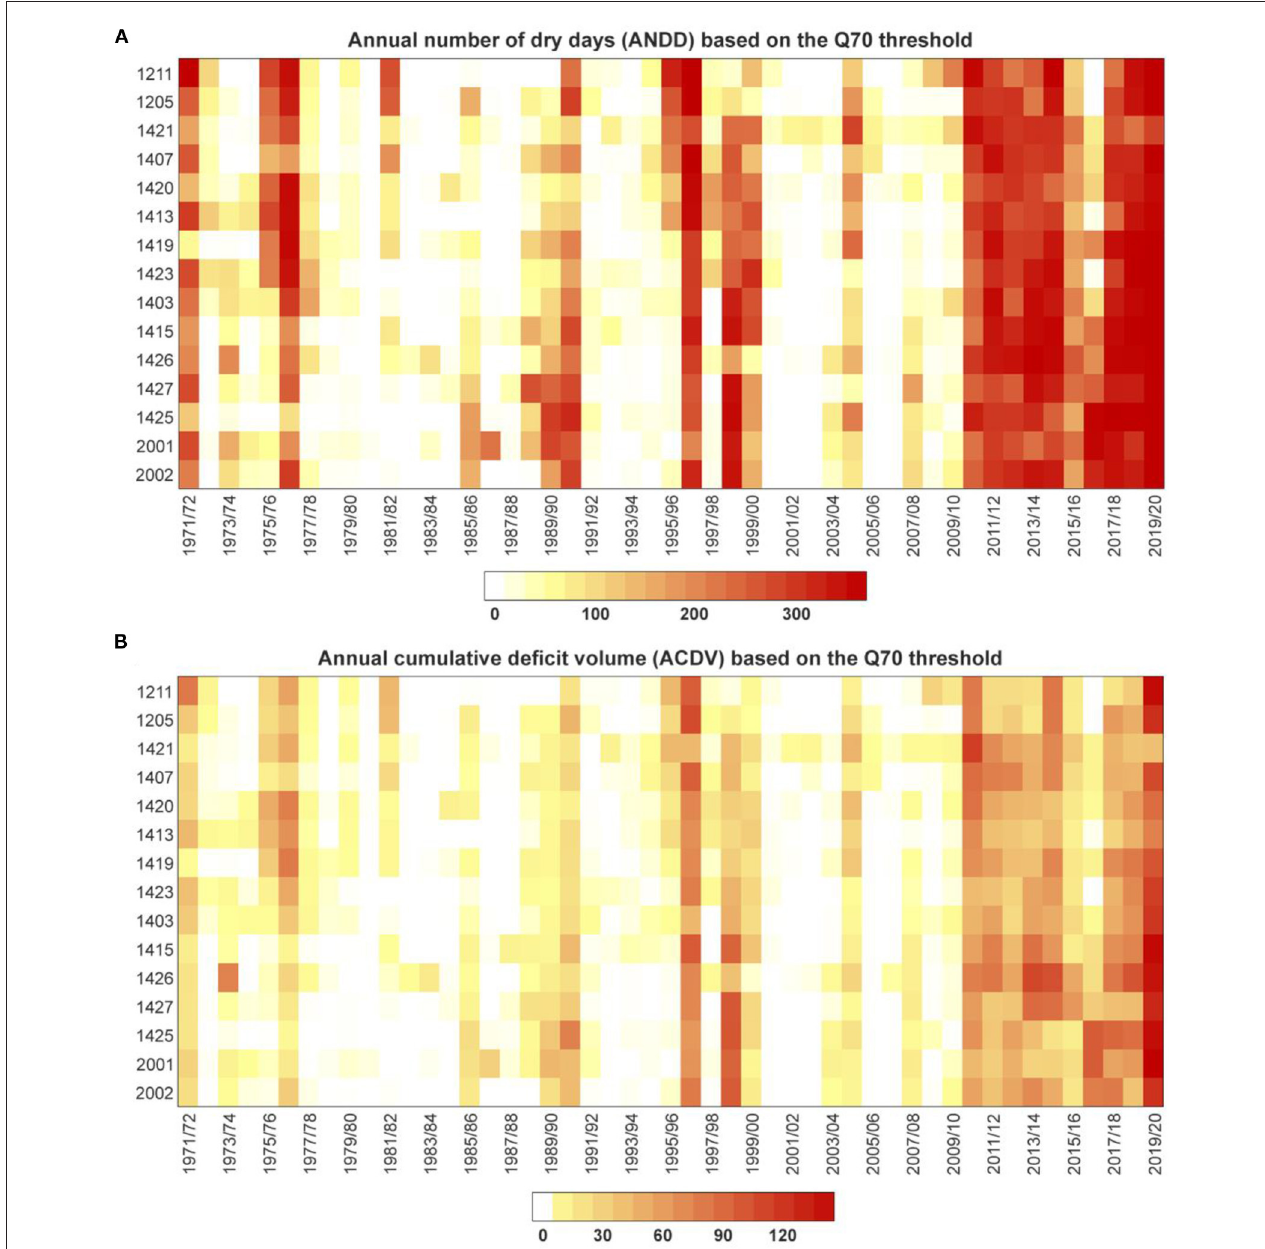
FIGURE 5 | (A) Heat map of the annual number of dry days (ANDD) based on the Q70 threshold for the 15 selected rivers of the CWA, arranged roughly from north to south on the y axis, for the 1971/72-2019/20 period. (B) Same as (A) for the annual cumulative deficit volume (ACDV) at each